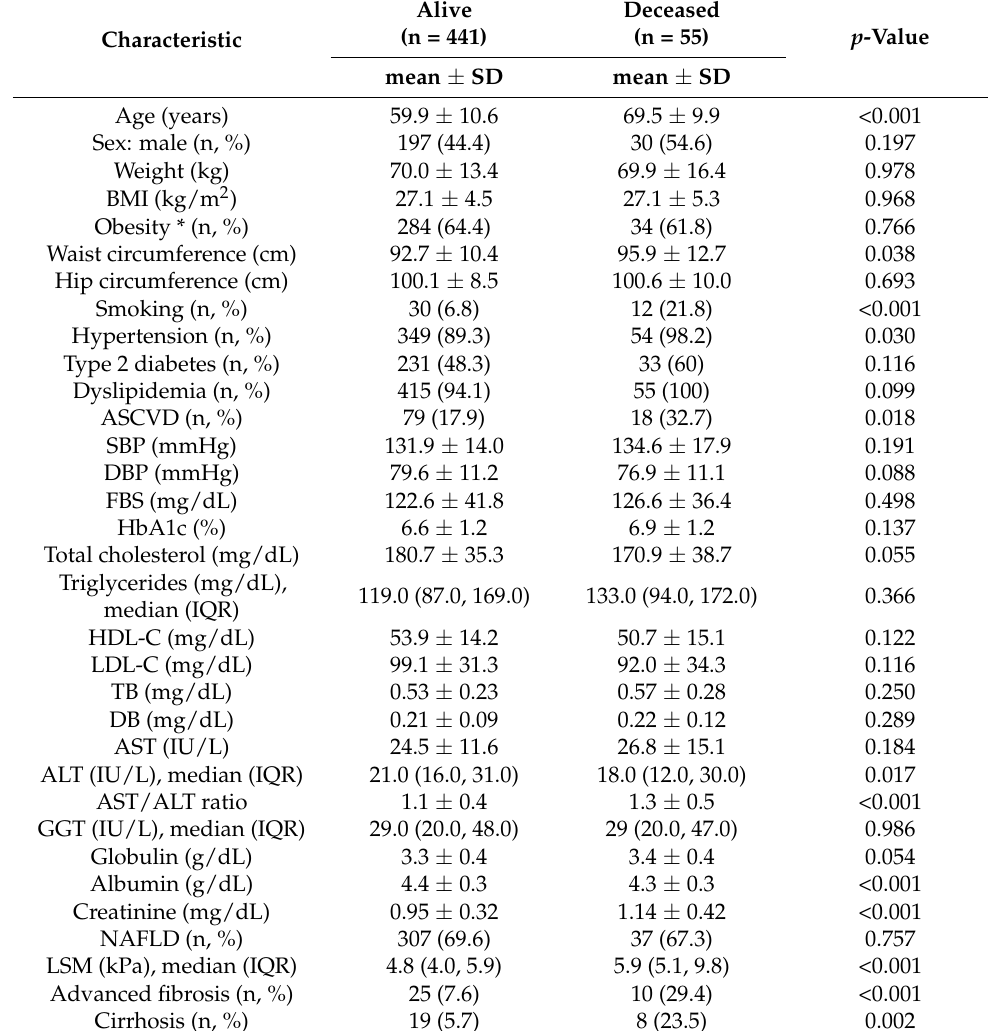
Table 2. Baseline clinical characteristics of survival and nonsurvival